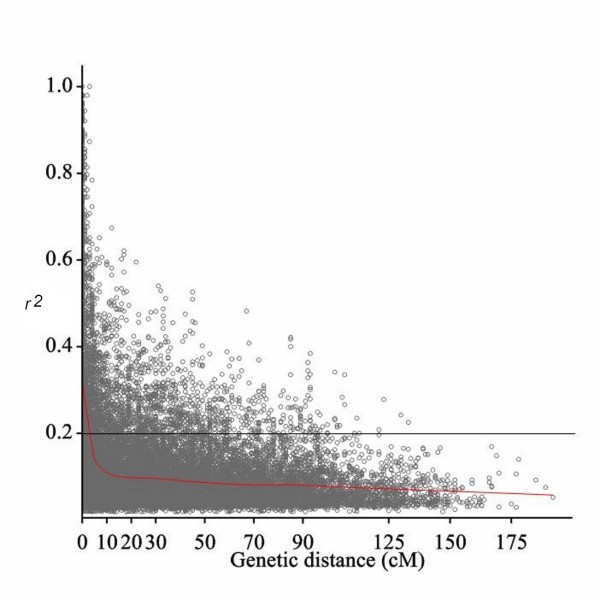
Intra-chromosomal LD (r2) decay of marker pairs over all chromosomes as a function of genetic distance (cM). The horizontal line indicates the 95th percentile distribution of unlinked r2. The LOESS fitting curve (red line) illustrates the LD decay